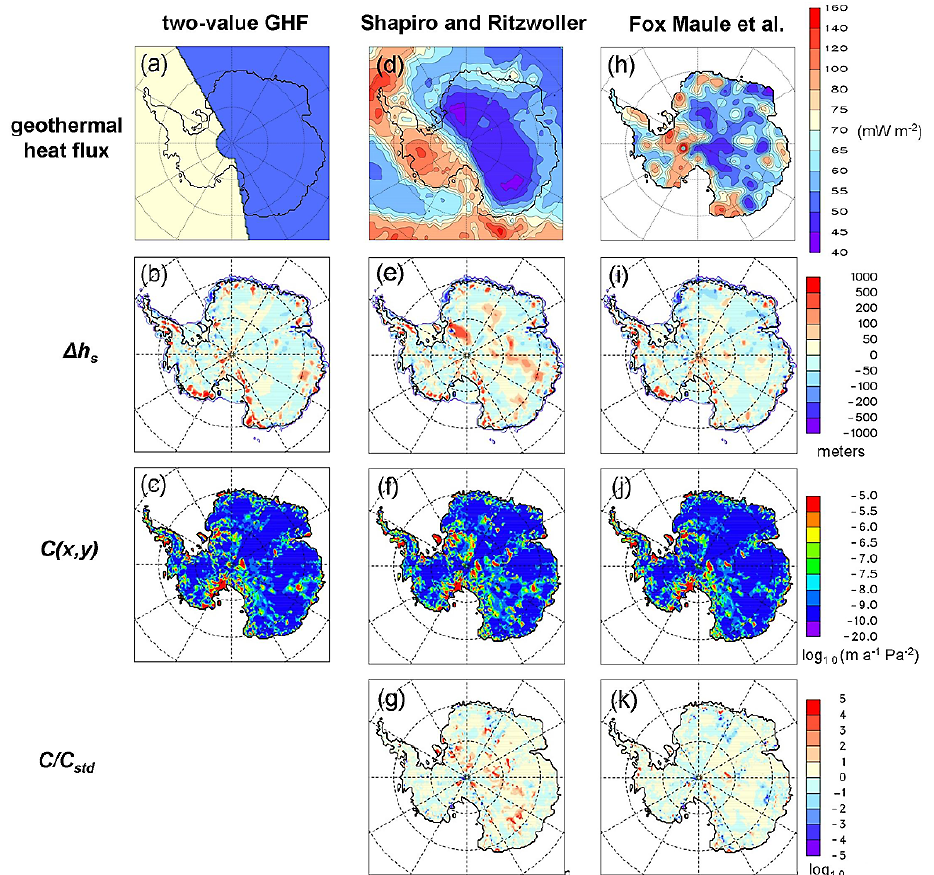
Fig. F1. Inverse runs with sub-grid topographic influence, and various prescribed geothermal heat flux (GHF) distributions. Top row: GHF, mWm − 2 . Second row: model minus observed surface ice elevation, meters. Third row: basal sliding coefficients C(x,y) , log 10 (ma − 1 Pa − 2 ) . Bottom row: ratio of C(x,y) to that in (c) , i.e., log 10 (C/C panel(c) ). Left column (a–c) : with simple 2-valued GHF, default for this paper. Middle column (d–g) : with Shapiro and Ritzwoller (2004) GHF. Right column (h–k) : with Fox Maule et al. (2005)